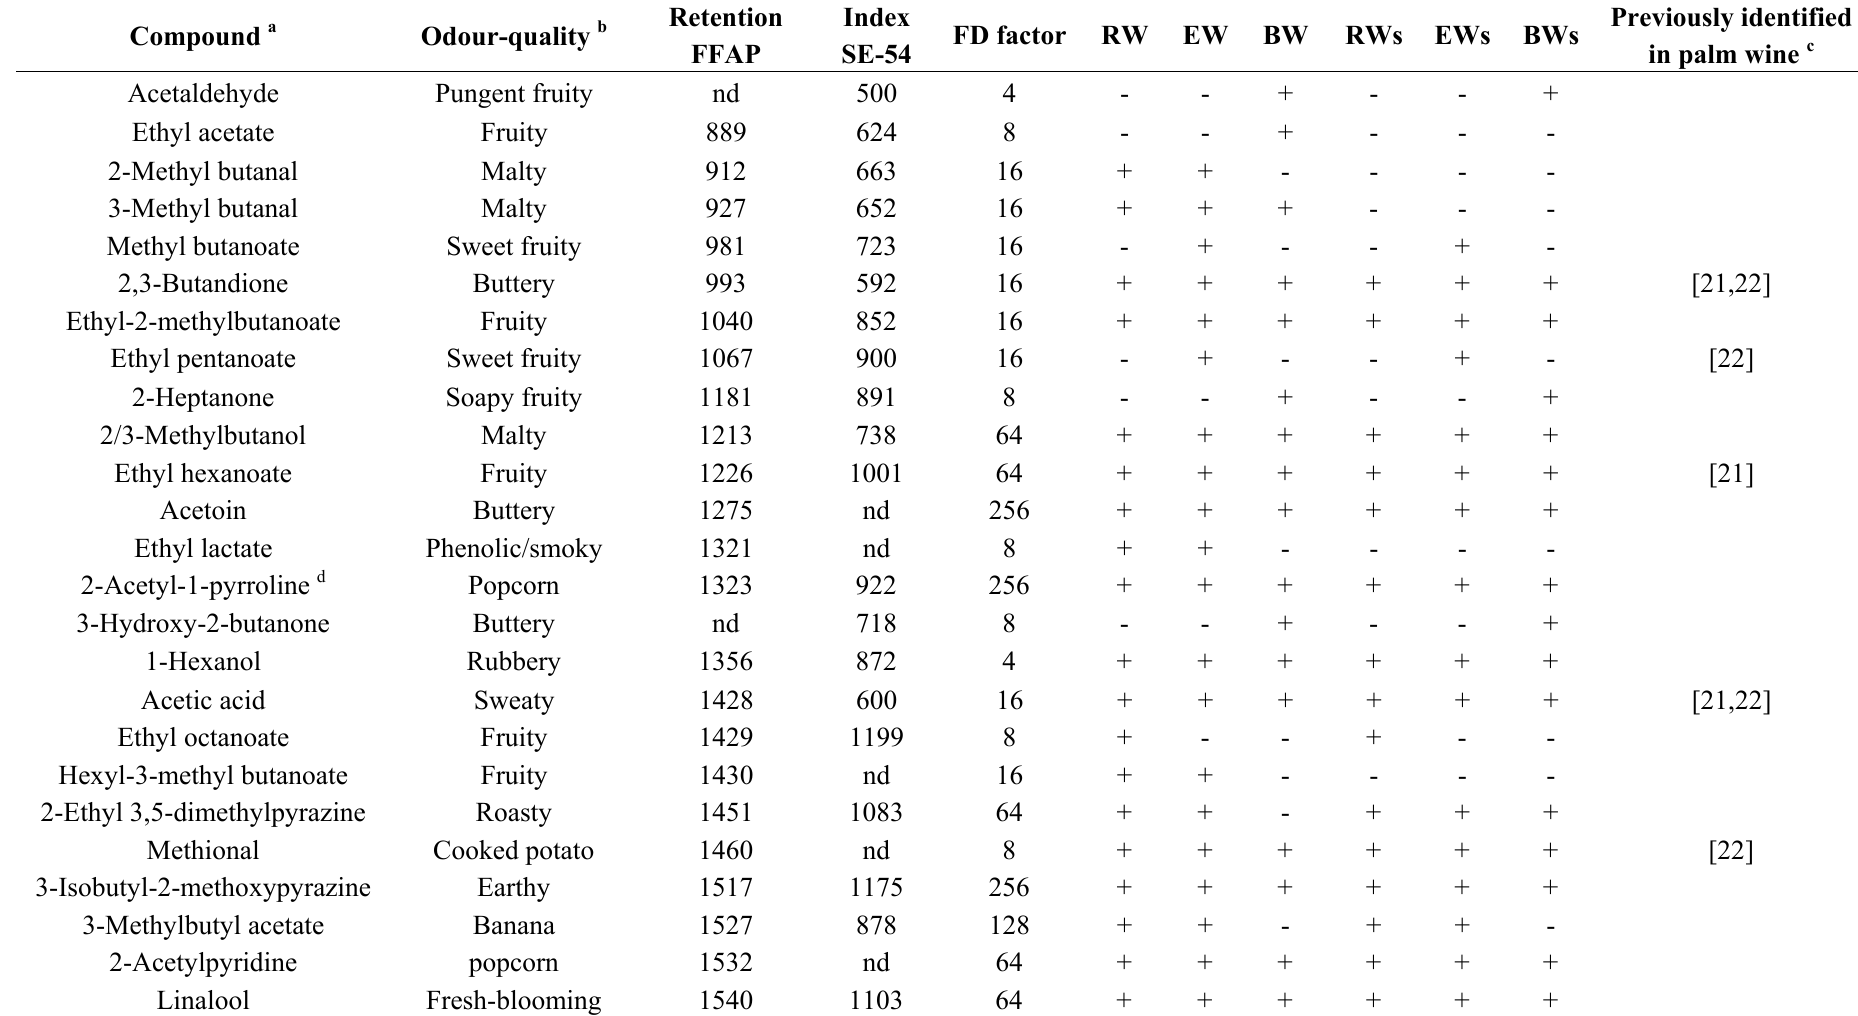
Table 1. Most odour-active volatiles in solvent-extracted palm wines and wines with adjusted pH + saliva. Compound